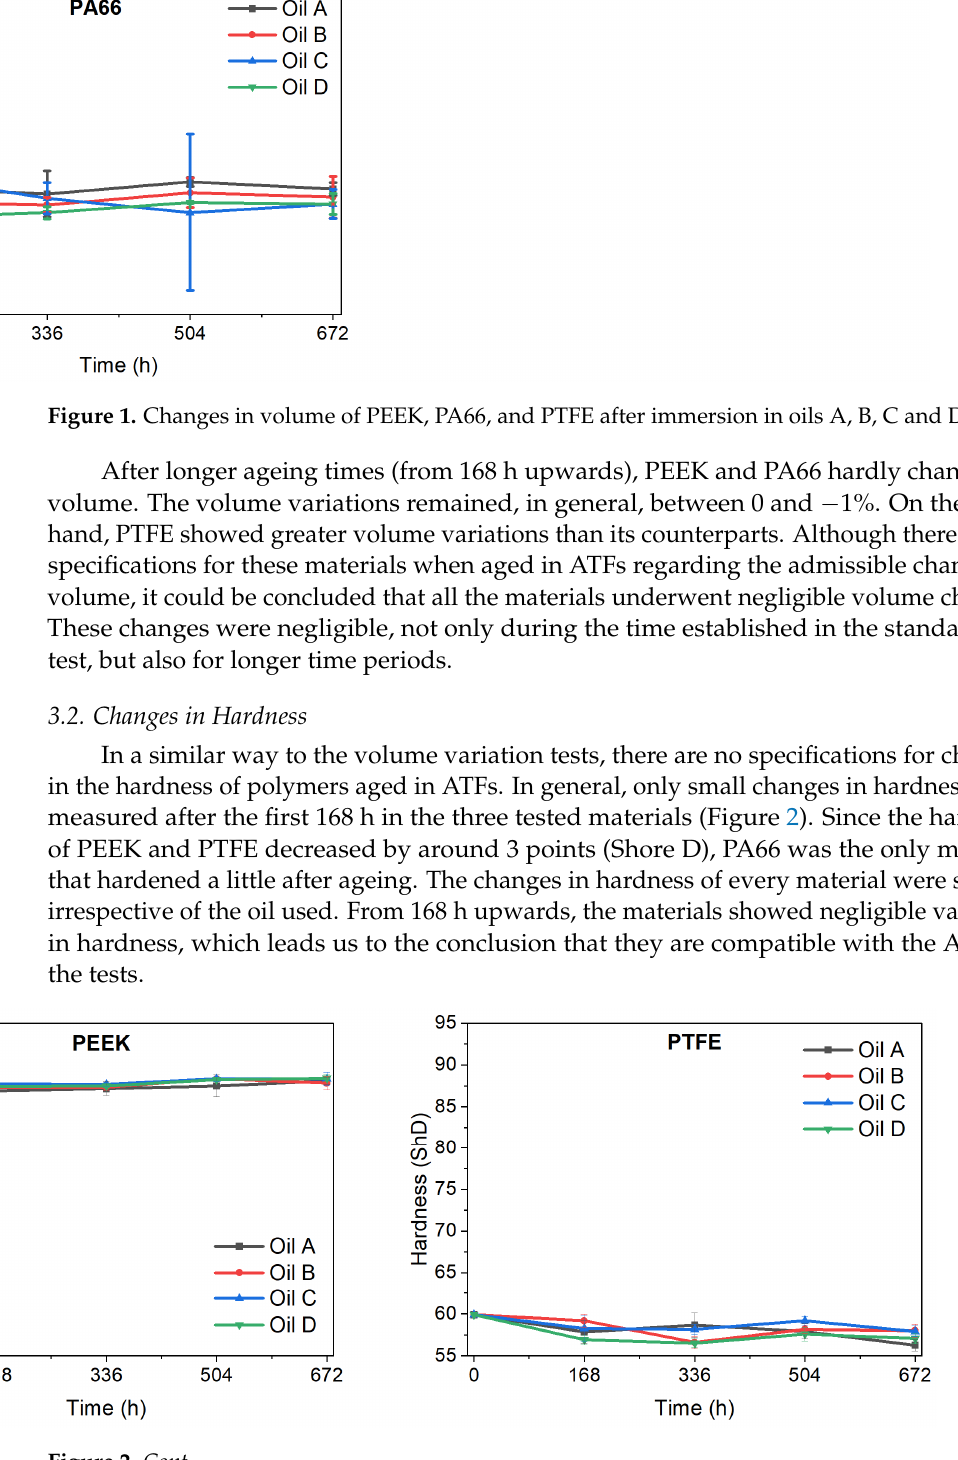
Figure 2. Changes in hardness of PEEK, PTFE, and PA66 (Shore D) after immersion in the ATFs. 3.3. Changes in Tensile Strength and Elongation at Break The stress–strain curves of all materials were obtained before and after their ageing in the ATFs for different periods of time (see Supplementary Information, Figures S1–S3), and the tensile strength and the elongation at break were obtained from these curves. The polymers had two types of tensile strength behaviour at an aging time of 168 h (Figure 3), depending on the ATF used. On one hand, the PEEK and PA66 tensile strength variation did not depend on the oil used. On the other hand, PTFE showed mean tensile strength variations of between − 1.5% (oil A) and − 6% (oil C). Nevertheless, while the tensile strength of PEEK remained constant, regardless of the oil and the ageing time used, this property increased slightly for PA66 and decreased slightly for PTFE. From 168 h upwards, all materials maintained relatively constant tensile strength values. PEEK and PTFE seem to be compatible with these ATFs, showing low tensile strength variations (null in the case of PEEK), but PA66 should be studied further.